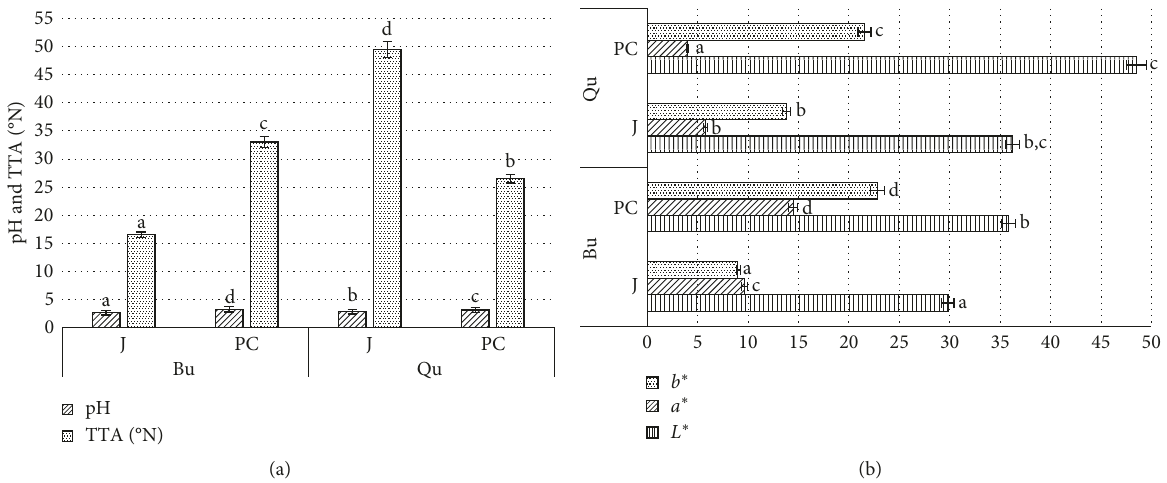
Figure 1: Acidity parameters (a) and colour coordinates (b) of sea buckthorn (Bu) and quince (Qu) juice (J) and juice by-products (PC) (BuJ, QuJ, BuBP, and QuBP,